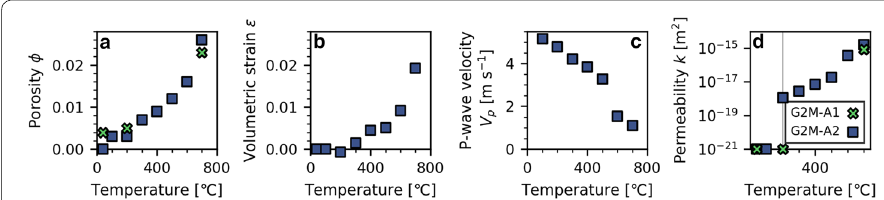
Fig. 5 Physical property evolution of G2M-A granite sample through iterative heating cycles. a Porosity evolution with heat treatment. b Volumetric strain evolution. c P-wave velocity decrease with heating. d Permeability change with heating. Vertical line highlights the onset of detectable permeability